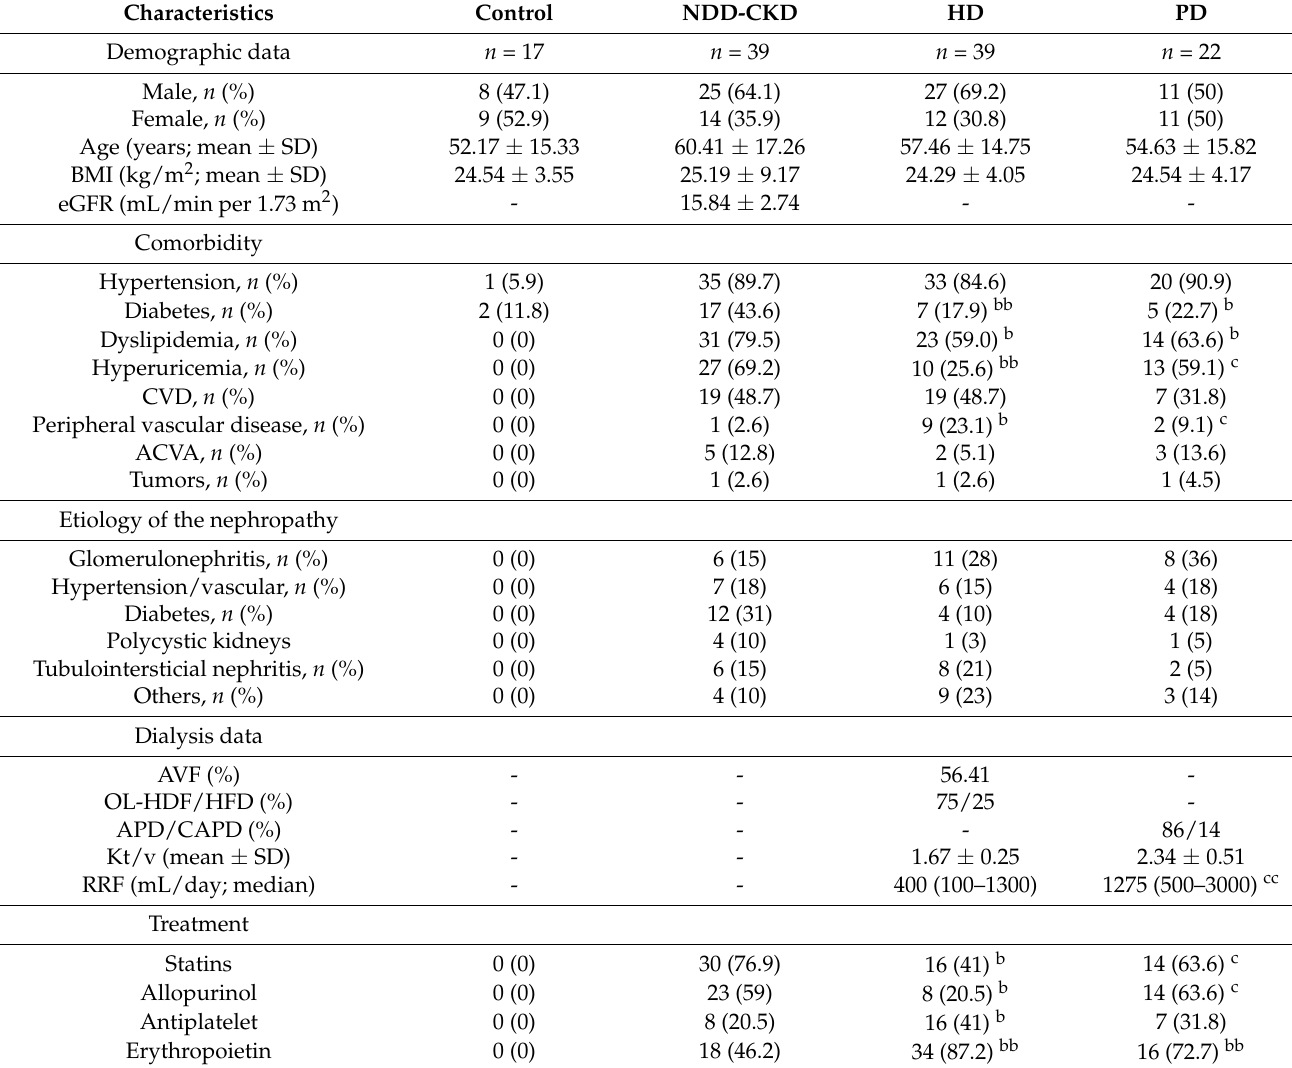
Table 1. The demographic and clinical characteristics of the study